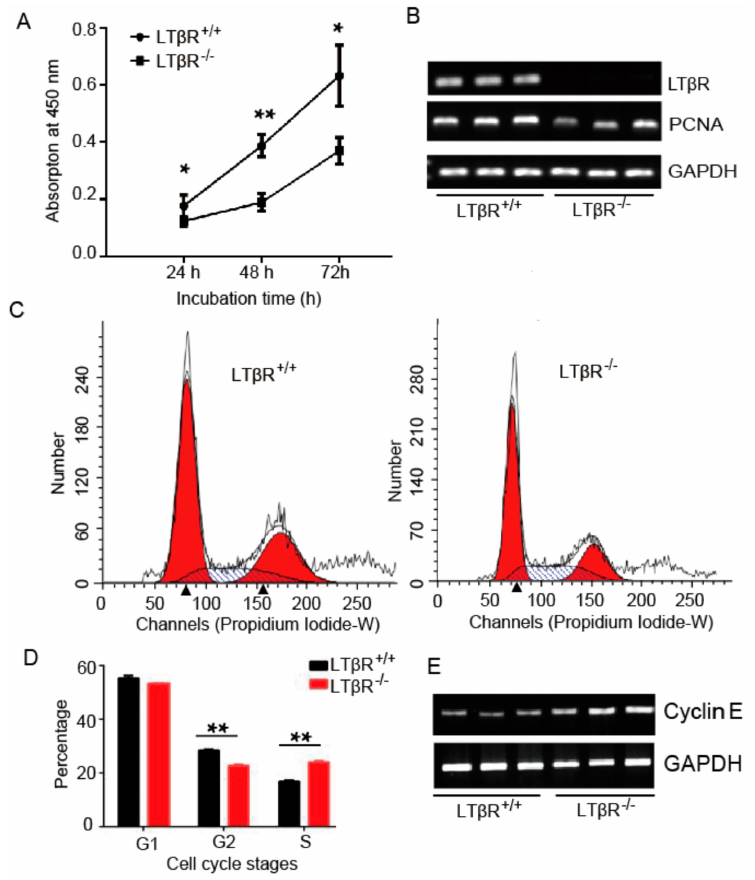
Figure 3. The effect of LT β R on IPEC-J2 cell proliferation and cell cycle progression. ( A ) LT β R +/+ and LT β R − / − cells were plated and cultured for various times, and the number of proliferating cells was quantified by the Cell Counting Kit-8 (CCK-8) method. The results shown are representative of three different experiments * p < 0.05 and ** p < 0.01. ( B ) Semi-quantitative PCR of LT β R and proliferating cell nuclear antigen (PCNA) in both cells. ( C ) LT β R +/+ and LT β R − / − cells were serum-starved for 24 h and stimulated with serum. After 24 h, the DNA content of incorporated propidium iodide was scanned on a flow cytometer. Each scan is derived from a representative experiment, where the data from at least 10,000 events were obtained. ( D ) Cell populations in G1, S, and G2 were determined using ModFit software (BD Biosciences, San Diego, CA, USA), ** p < 0.01. ( E ) Semi-quantitative PCR of Cyclin E in both